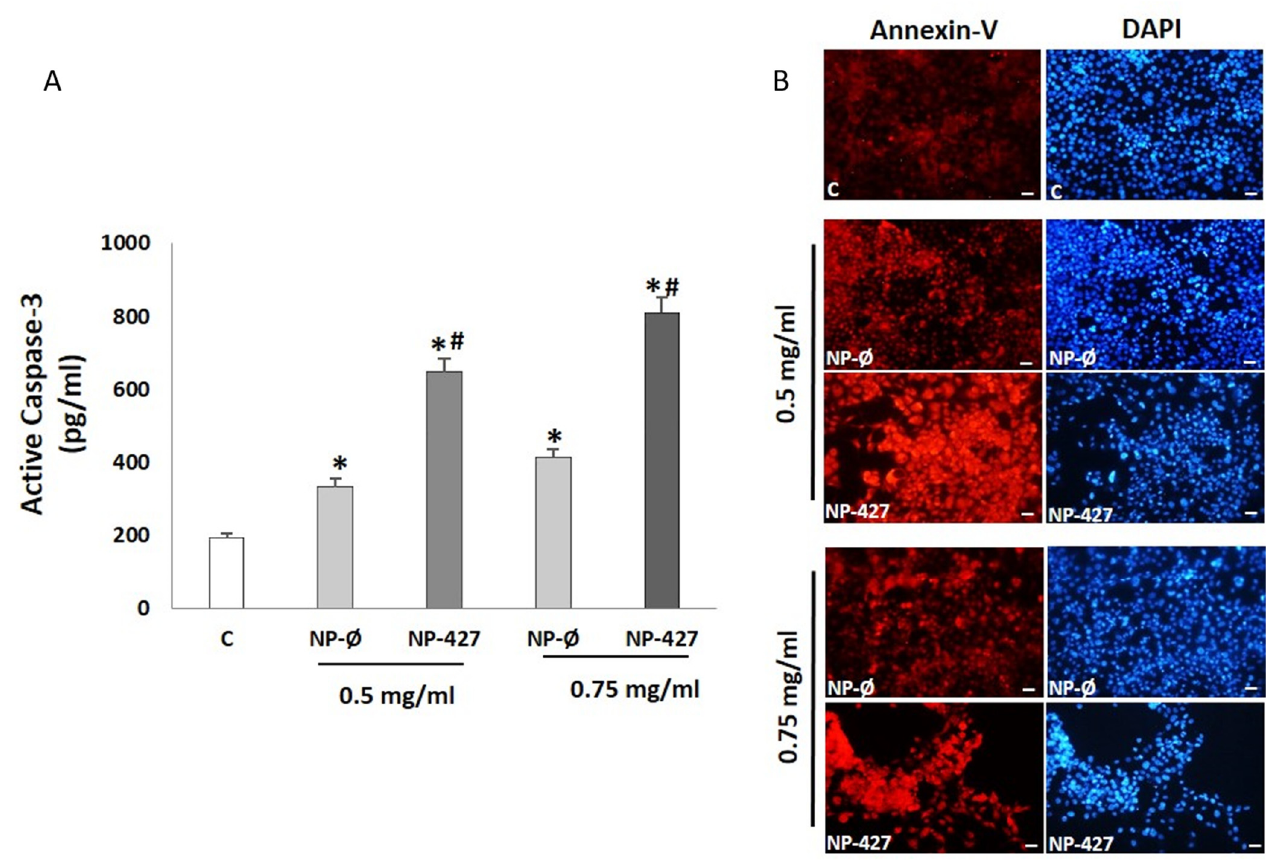
Figure 3. NP-427 increase the production of apoptosis in FaDu cells. ( A ) Caspase-3 in FaDu cultures treated with: C (control), NP-Ø (unloaded NPs, 0.5 and 0.75 mg/mL), and NP-427 (PHT427-loaded NPs, 0.5 and 0.75 mg/mL) for 24 h. The diagrams include the mean ± SD (pg/mL) ( n = 4). * p < 0.05 versus control group and # p < 0.05 versus NP-Ø group. ( B ) Representative fluorescence micrographs of the immunostaining of Annexin-V (red fluorescence) in FaDu cultures treated with C (control), NP-Ø (unloaded NPs, 0.5 and 0.75 mg/mL), and NP-427 (PHT427-loaded NPs, 0.5 and 0.75 mg/mL) for 24 h. Nuclei (blue fluorescence) were identified by DAPI. Scale bar: 100 µm.